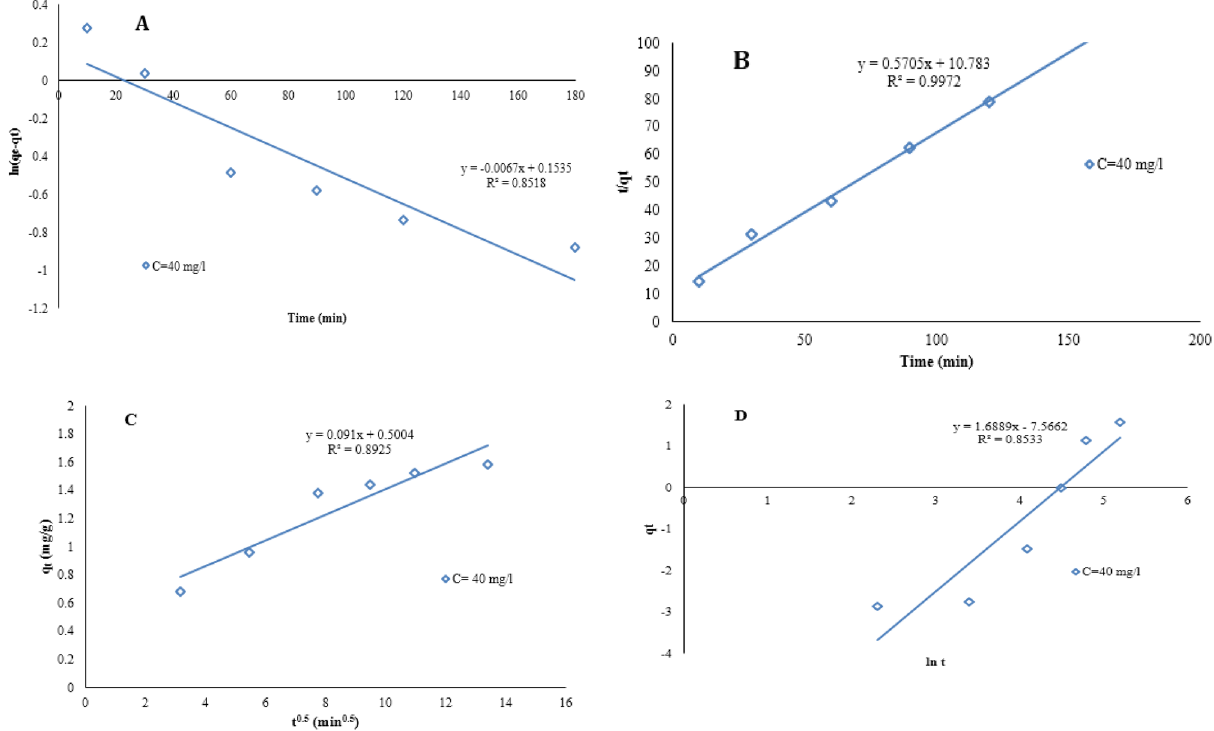
Figure 9. The kinetic models for the removal of Cd by MBA nano-hybrid: ( a ) Pseudo-first order, ( b ) Pseudo- second order, ( c ) Intra-particle ( d ) and Elovich models (pH = 7.0, adsorbent = 1.0 g/L, temperature = 25 °C, optimum time = 60